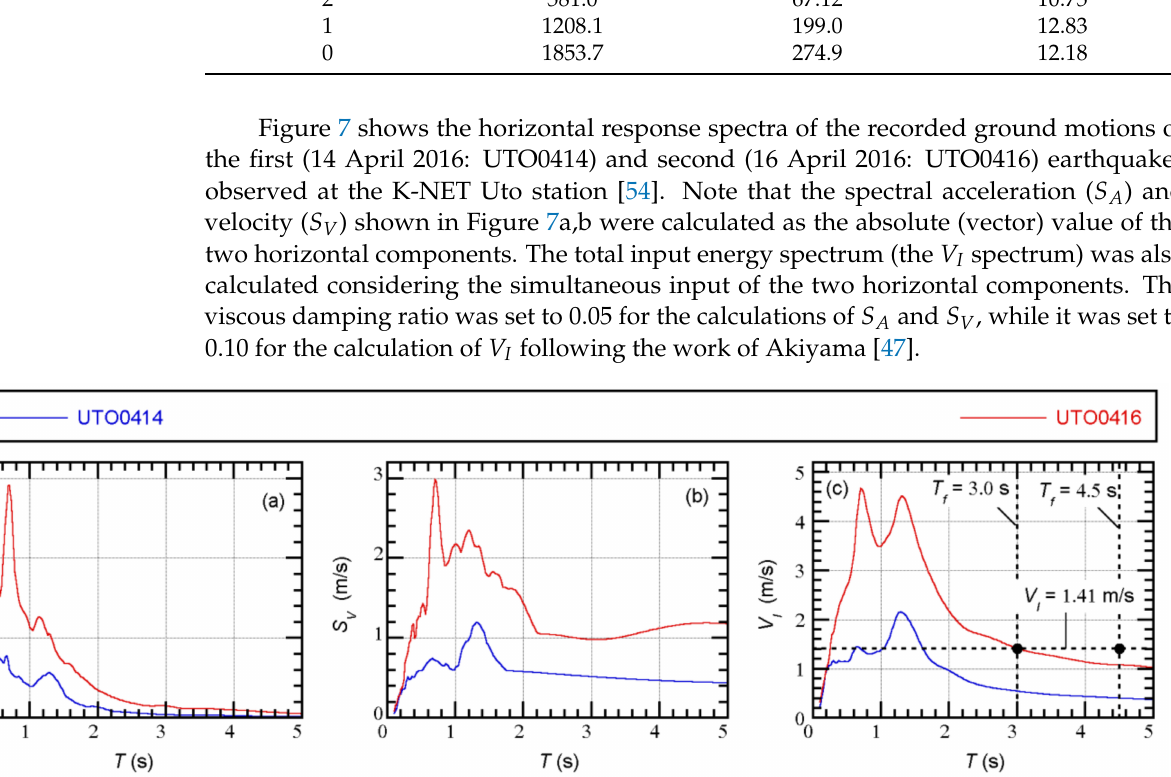
Figure 7. Horizontal response spectra of the recorded ground motions at the K-NET Uto station: ( a ) Elastic acceleration response spectrum (damping ratio: 0.05); ( b ) elastic velocity response spectrum (damping ratio: 0.05); ( c ) elastic total input energy spectrum (damping ratio: